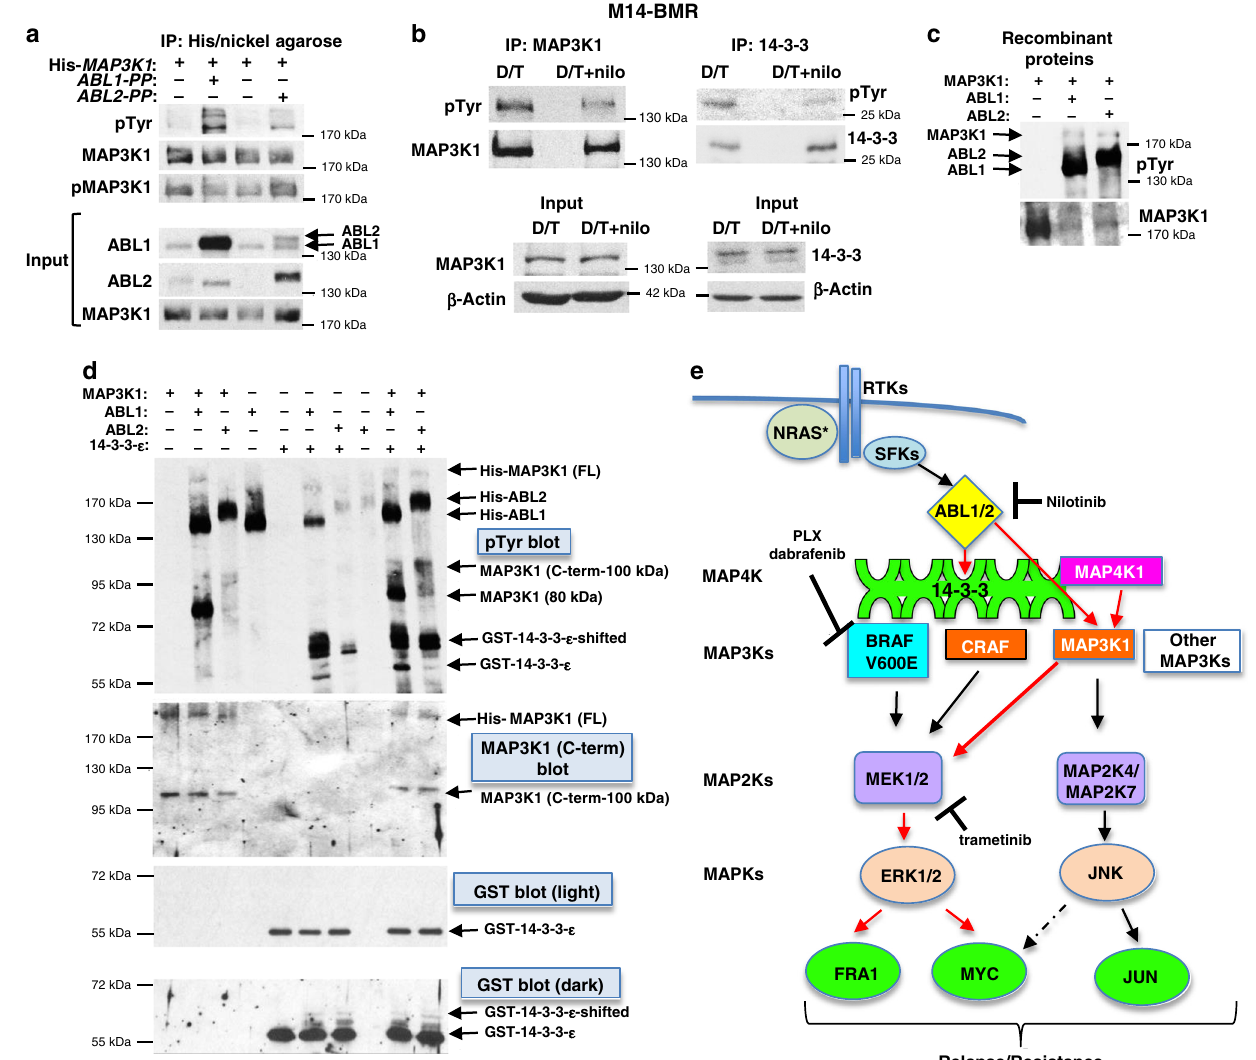
Fig. 7 ABL1/2 phosphorylate MAP3K1 and 14-3-3- ε . a 293T cells were transfected with His- MAP3K1 and/or constitutively active forms of ABL1 or ABL2 (PP), His- MAP3K1 pelleted with nickel agarose, complexes blotted with phospho-tyrosine (pTyr) antibody, and blot stripped and reprobed with control antibodies. Blots shown are representative of n = 3 independent experiments. b Endogenous MAP3K1 or 14-3-3 (pan) were immunoprecipitated from M14- BMR cells, and IPs blotted with the indicated antibodies. Blots shown are representative of n = 2 independent experiments. c Recombinant forms of ABL1 or ABL2 were incubated with full-length, recombinant MAP3K1 in a “ cold ” in vitro kinase assay, and reactions blotted with phospho-tyrosine (pTyr) antibody, stripped and reprobed with antibody to MAP3K1. Blots shown are representative of n = 2 independent experiments. d Recombinant proteins were incubated in a kinase assay as in c using either His-MAP3K1, GST-14-3-3- ε , or the combination as substrates. The phospho-tyrosine blot (top) was stripped and reprobed with antibody directed at the MAP3K1 C-terminus (middle) or GST (bottom; to visualize 14-3-3). Blots shown are representative of n = 2 independent experiments. e Scheme showing mechanism by which ABL1/2 drive ERK reactivation and resistance (red